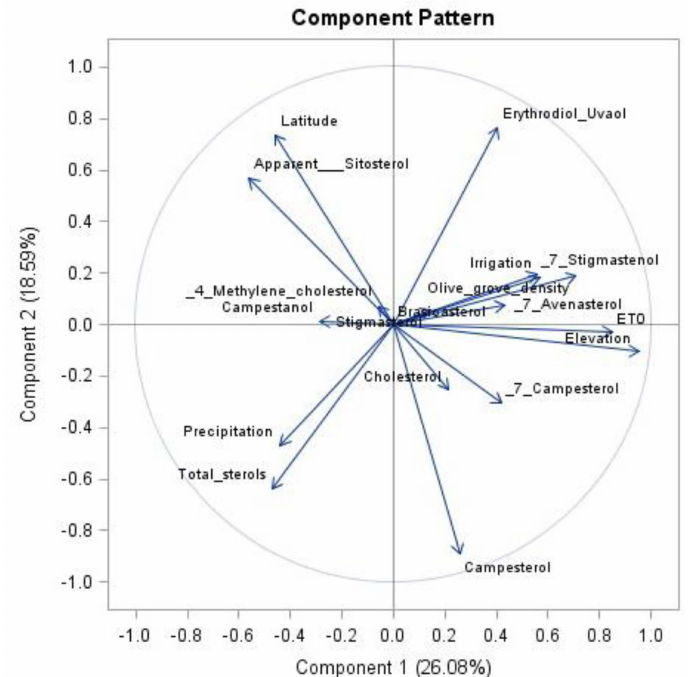
Figure 5. Principal component analysis (PCA) biplot (44.67 % of explained variance) after Varimax rotation including main meteorological and orchard characteristics and the sterols and triterpenes dialcohols